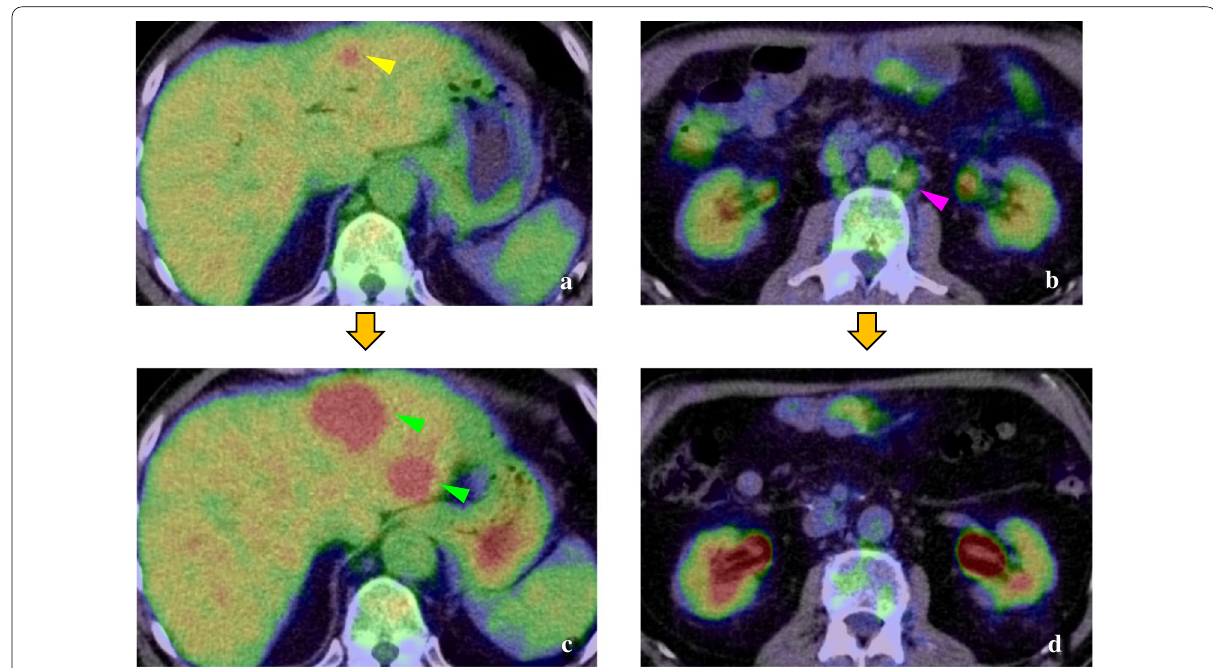
Fig. 2 Fluorodeoxyglucose positron emission tomography–computed tomography. The abnormal uptake of the liver metastasis in segment 3 ( a yellow arrowhead; SUV* max was 4.65) and para-aortic lymph nodes were identified ( b pink arrowheads; SUV max was 2.53) 12 months after laparoscopic pancreatoduodenectomy. After six courses of chemotherapy, the uptake of the liver lesion was stronger ( c green arrowheads; SUV max was 7.47), but the uptake of the para-aortic lymph nodes vanished ( d SUV max was 1.70). *: standardized uptake value